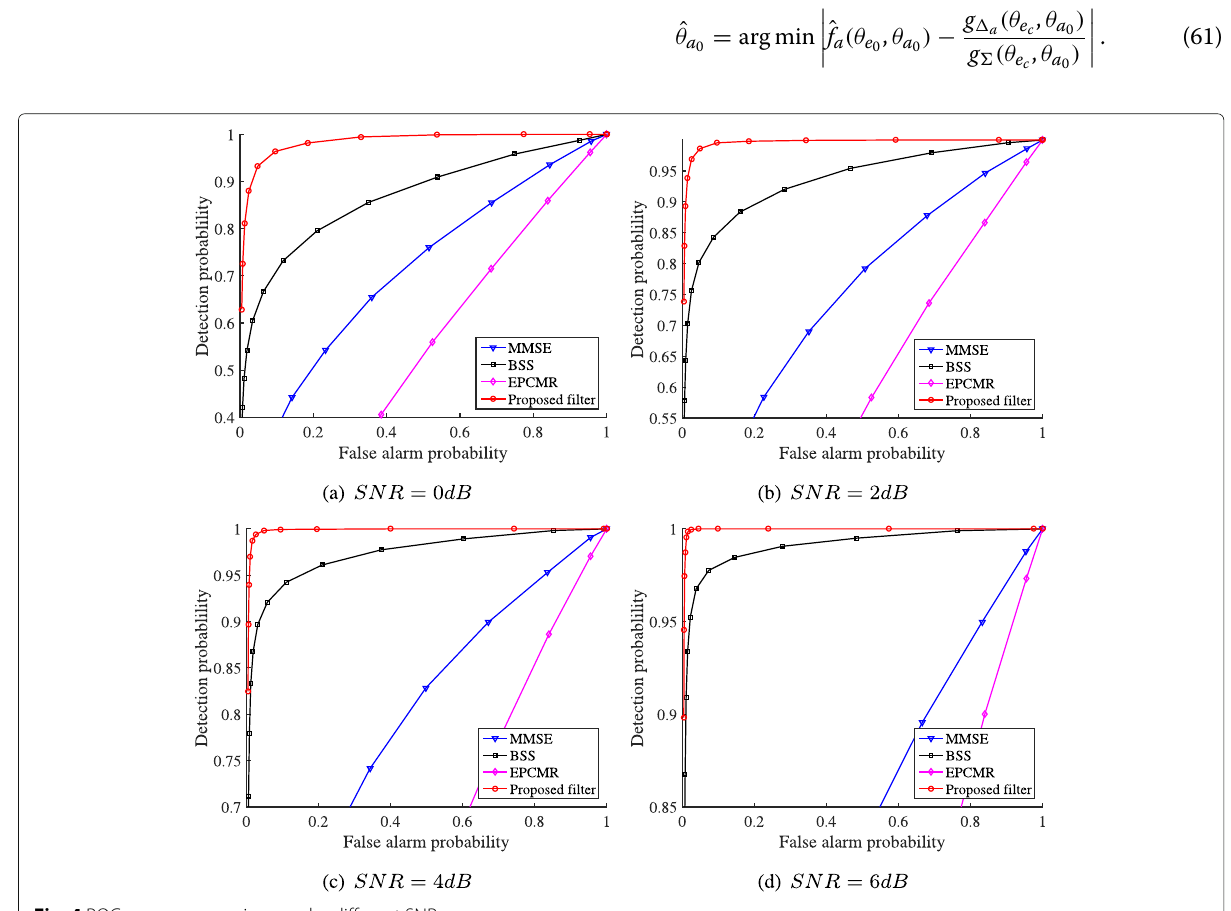
Fig. 4 ROC curves comparison under different